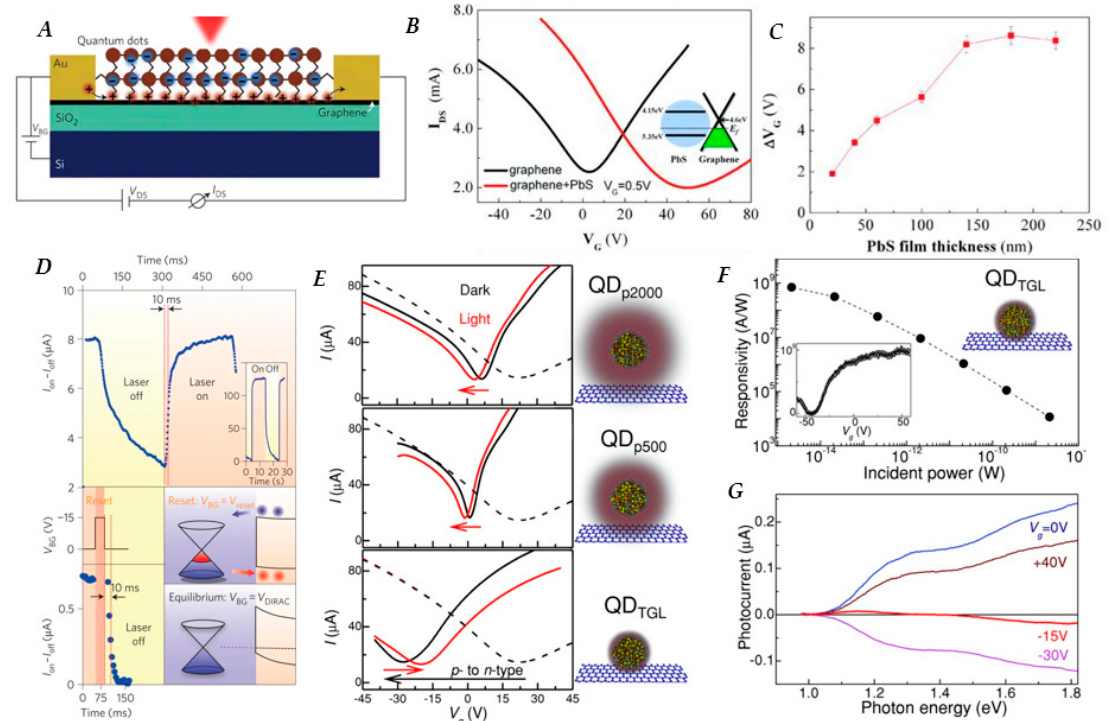
Figure 4. ( A ) Schematic representation of a typical graphene-QD hybrid phototransistor, in which graphene acts as gate modulated transport layer for holes; ( B ) Transfer characteristics (source-drain current ( I DS ) ~ V G , V DS = 0.5 V) of bare un-doped graphene transistors before (black) and after the deposition of PbS QDs on the graphene film (red). Indication of p- type doping in the graphene film is shown by the transfer curve becoming asymmetric and the Dirac point shifting to a positive gate voltage (~50 V) after deposition. Inset: energy diagram of the heterojunction of PbS QD and graphene (valence and conduction band values of the PbS QD are 5.35 eV and 4.15 eV respectively, while the value for graphene reads 4.6 eV) ; ( C ) Horizontal shift of the transfer curves ( I DS ~ V G , V DS = 0.5 V) of the hybrid graphene-PbS QDs devices with different thicknesses of PbS QDs layers under irradiation with 6.4 mW cm − 2 of 895 nm light. Saturation after 150 nm indicates that any carriers generated further than 150 nm from graphene layer are not collected; ( D ) [Top] Photocurrent response as a function of time of a hybrid graphene-PbS QDs phototransistor. The temporal response indicates a rise time of ~10 ms, and two different fall times on the order of 100 ms (50%) and 1s. Inset, measured at a higher power of 267 pW; [Bottom] temporal response of a bilayer graphene phototransistor after the laser is turned off and application of a reset pulse for 10 ms. The fall time is reduced from several seconds to ~10 ms. Insets: energy diagrams showing effect of reset pulse lowering potential barrier allowing electrons trapped at graphene-QD barrier to escape; ( E ) Transfer characteristics ( I DS - V G , V DS = 0.1 V) of p -doped graphene phototransistors before (dashed lines) and after (black) deposition of PbS QD with varying ligand length (schematic not to scale) red line is transfer curve under illumination with unfocused laser light ( λ = 514 nm) with P = 10 W m − 2 . Size of shift after deposition is an indication of coupling between graphene and QD layer; shift upon illumination is an indication of charge transfer of photoexcited carriers. ( F ) Responsivity as a function of incident power for hybrid detector using short thioglycerol (TGL) ligands. Inset: responsivity as a function of V G ; ( G ) Photocurrent dependence on photon energy of the incident light (P ≈ 10 − 11 W) at different gate voltages for same device as Figure ( F ). Figure ( A , D ) reproduced with permission from [122]. Copyright Springer Nature, 2012. Figure ( B , C ) reproduced with permission from [132]. Copyright John Wiley and Sons, 2012. Figure ( E – G ) reproduced with permission from [133]. Copyright John Wiley and Sons,